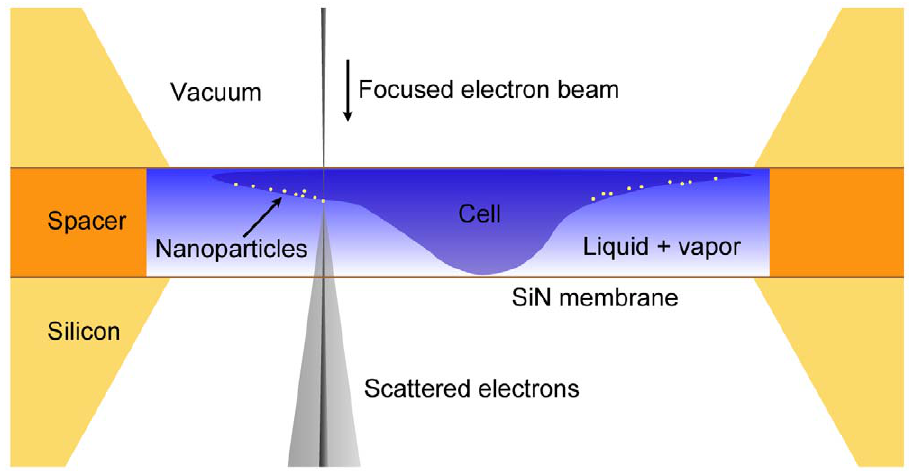
Figure 1. Schematic of the liquid enclosure for wet scanning transmission electron microscopy (STEM). A cell in a wet environment consisting of liquid and vapor is enclosed between two electron-transparent silicon nitride windows. The liquid enclosure is placed in the vacuum of the electron microscope. Images are obtained by scanning the electron beam and detecting elastically scattered transmitted electrons. Labels of a material of a high atomic number can be